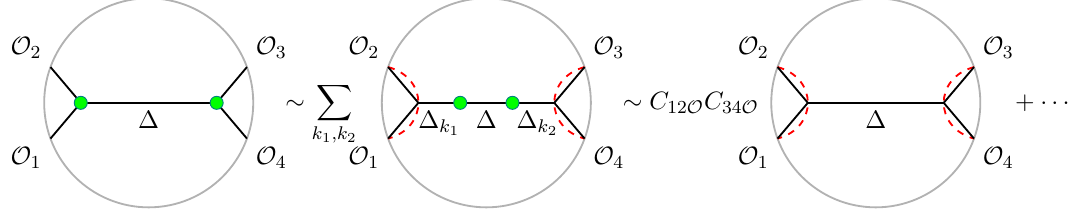
Figure 1 . Obtaining the conformal block decomposition of the four-point exchange diagram [1]. Green, disk-shaped bulk vertices are to be integrated over all of AdS. The remaining bulk vertices are integrated over boundary anchored geodesics, shown as dashed, red curves. Just for this (cid:12)gure, we have used the shorthand: (cid:1) k = (cid:1) 1 + (cid:1) 2 + 2 k 1 ; (cid:1) k = (cid:1) 3 + (cid:1) 4 + 2 k 2 . We used (A.1) to get 1 2 to the second step, and (A.2) to obtain the third step. The ellipsis in the third step corresponds to contributions from double-trace